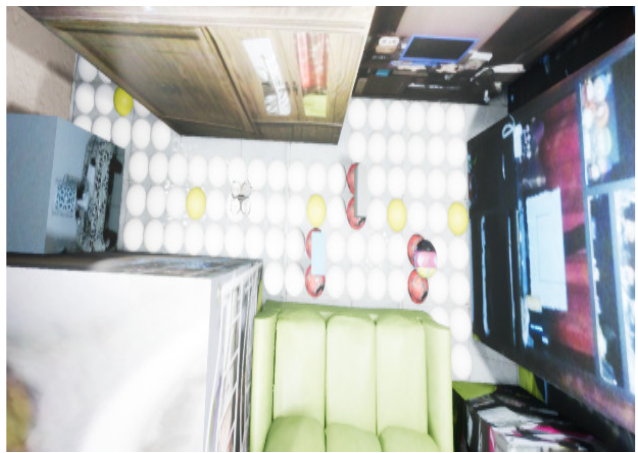
Figure 5. Representation of a 3D scenario that describes the free space for motion. The shortest path between an initial point and an endpoint in Figure 6 has 18 nodes.